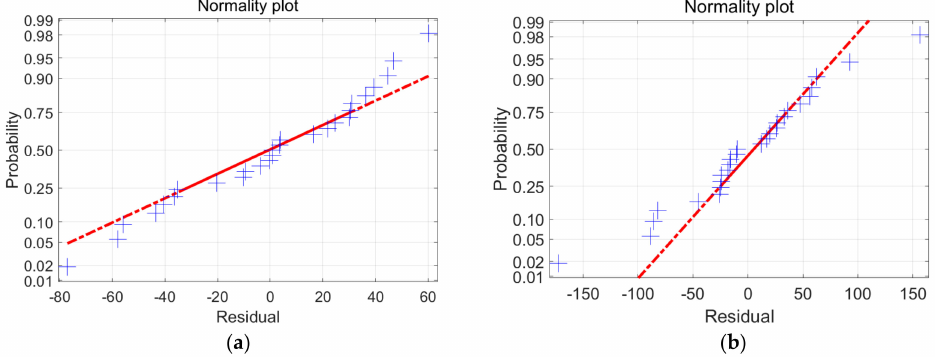
Figure 11. Normality plot. ( a ) Convex shape and ( b ) saddle